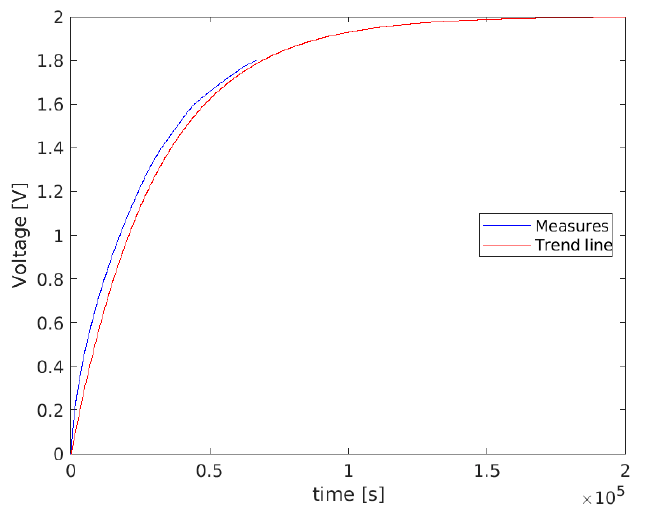
Figure 15. Waveforms of the charge time of the 10 F super capacitor with only one piezoelectric device.